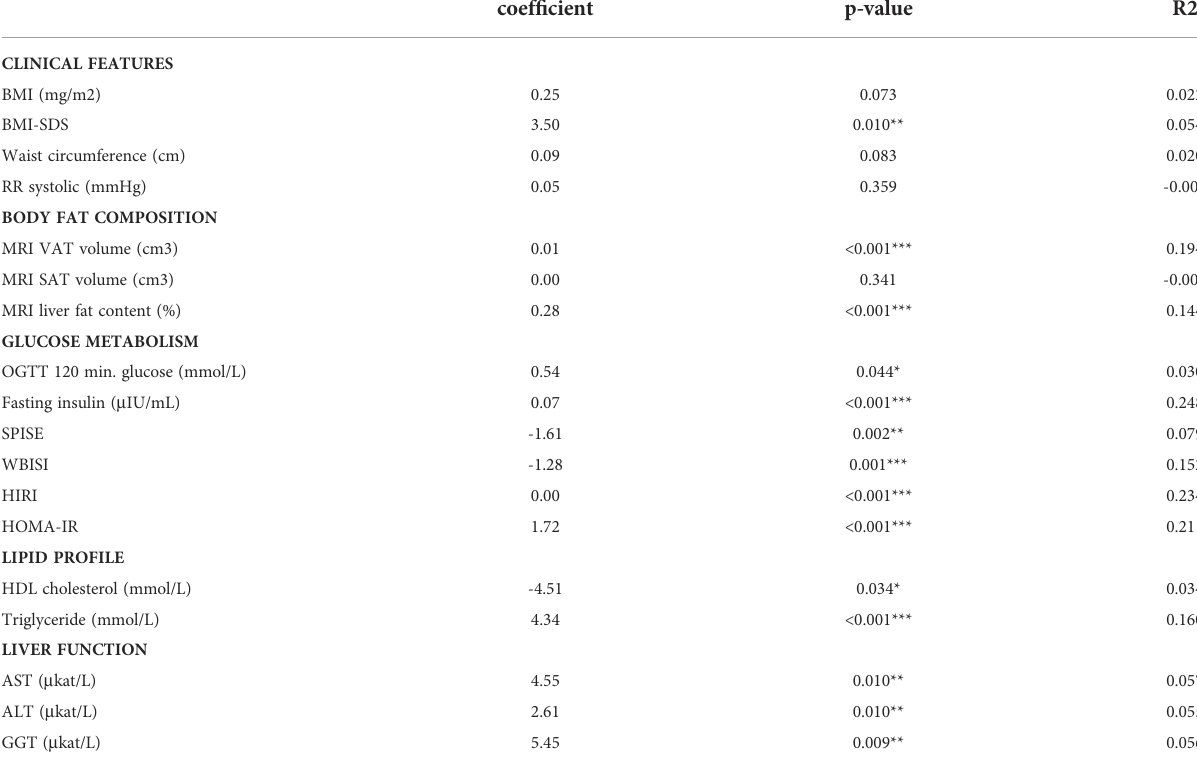
TABLE 2 Univariate analysi for fasting glucagon (pmol/L) in patient with overweight/obesity (n = 104#) matched for BMI-SDS. coef fi cient p-value